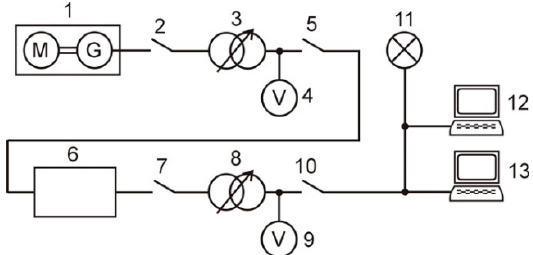
Figure 5. Diagram of the power supply system: 1, power generator; 2, 5, 7, 10, power connectors; 3, 8, autotransformer; 4, 9, voltmeter (multimeter); 6, voltage stabilizer; 11, light source installed in the luminaire (together with the necessary ignition system); 12, 13, PC.